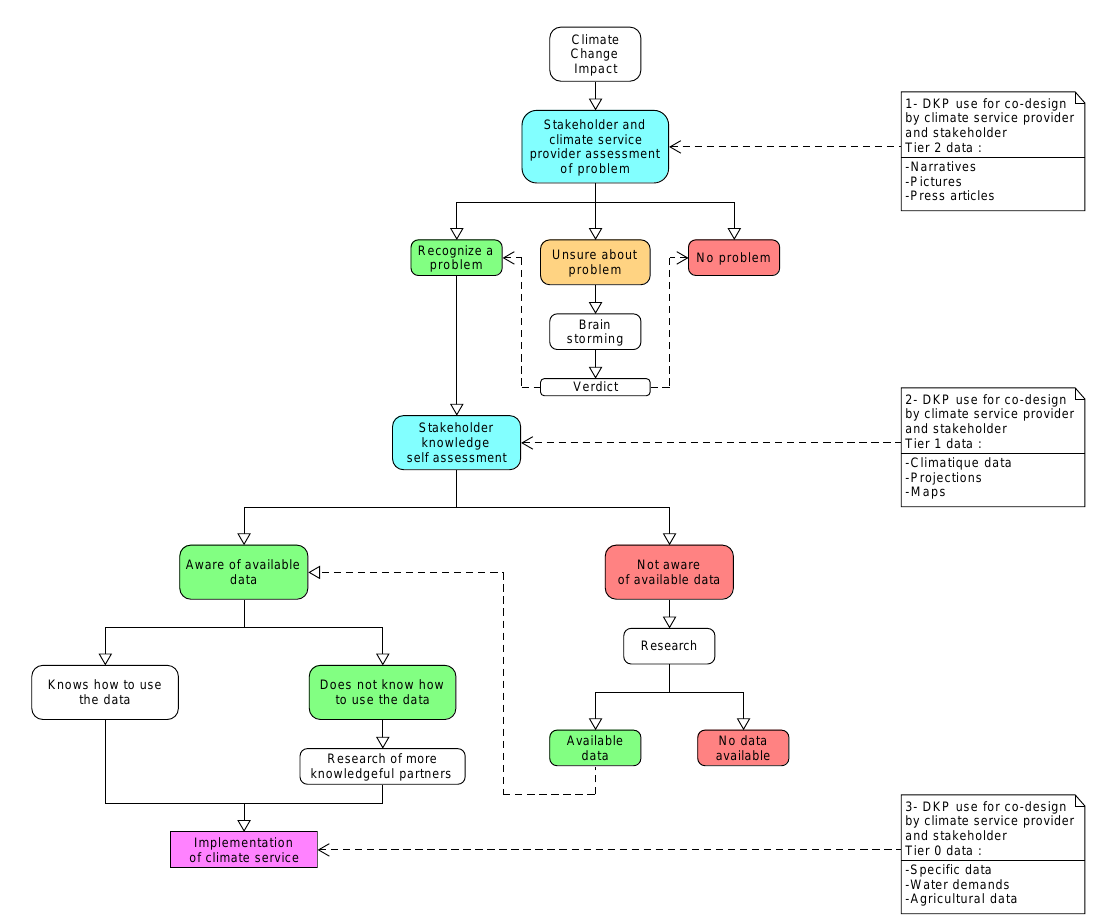
Figure 13. Co-design flow for developing climate services inspired by model defined by Rubio and et al. [13] inside the INNOVA project.